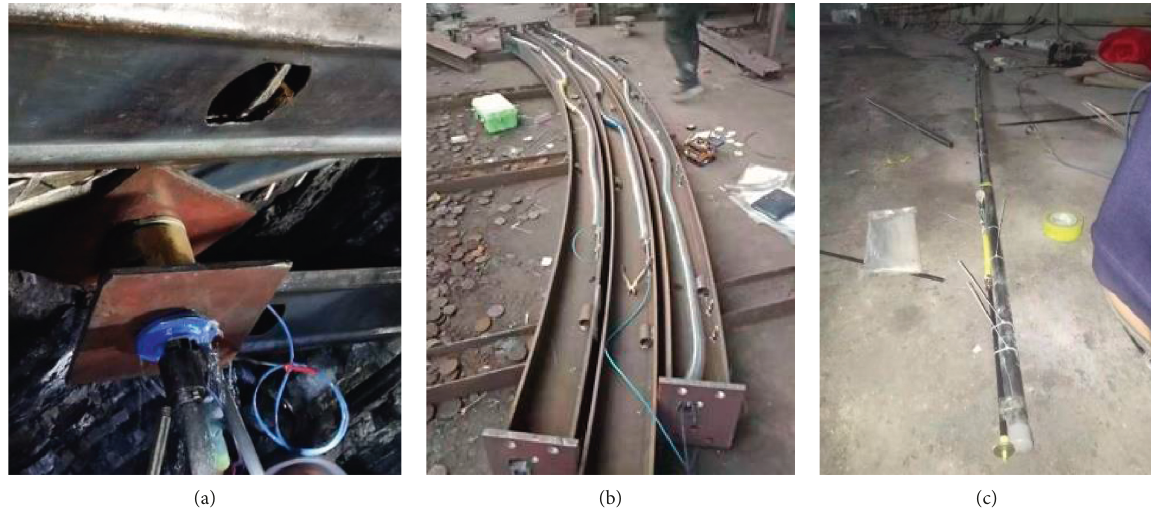
Figure 21: Installation of field testing equipment. (a) Anchor cable dynamometer. (b) Steel arch strain gauge. (c) Multipoint displacement